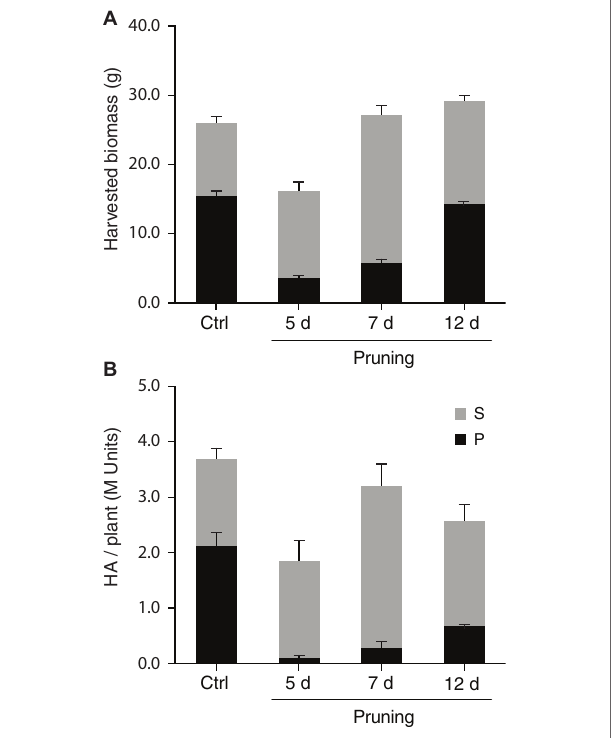
FIGURE 4 | Apex pruning positively influences axillary growth but has no positive impact on H1 yield per plant. Main stem apices were removed 5, 7, or 12 days after seedling transplantation, and the pruned plants then left to grow in greenhouse for an additional 16, 14, or 9 days, respectively, before vacuum infiltration and transfer in growth chamber. Harvested biomass was recorded (A) , and total H1 yield determined (B) , for P and S leaf production units following heterologous protein expression. Each bar is the mean of four independent (replication) values ± se . Ctrl, control, no-pruning treatment. P, leaf production units P1–P3; S, leaf production units